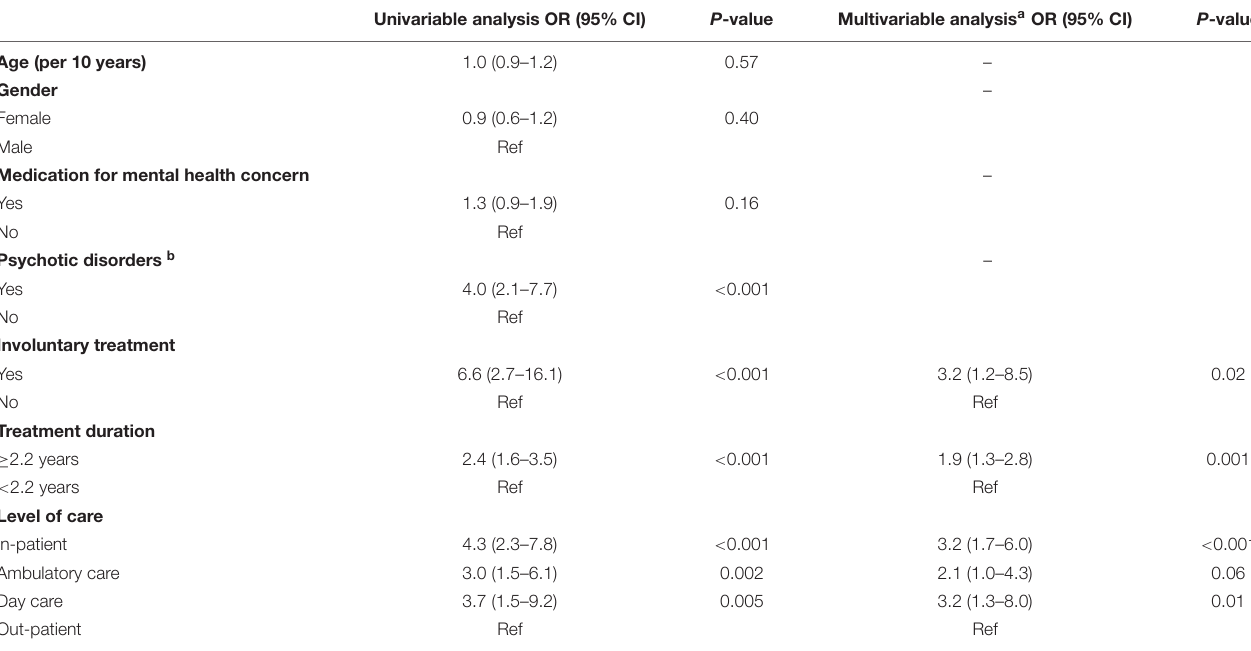
Univariable analysis OR (95% CI) P -value Multivariable analysis a OR (95% CI) P